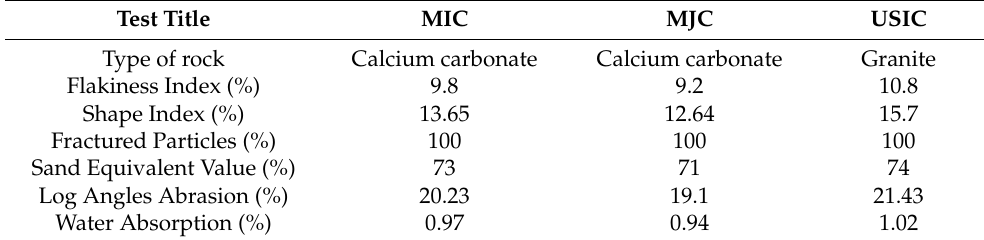
Table 6. Engineering properties of MIC, MJC and